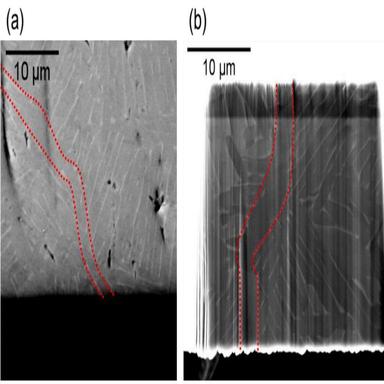
(a) A BSE image of the top surface used to select the location of a pillar for 3D EBSD with a prior β grain boundary highlighted in red. (b) A BSE image of the front face of the pillar with the same prior β grain boundary highlighted. (For interpretation of the references to color in this figure legend, the reader is referred to the web version of this article.)